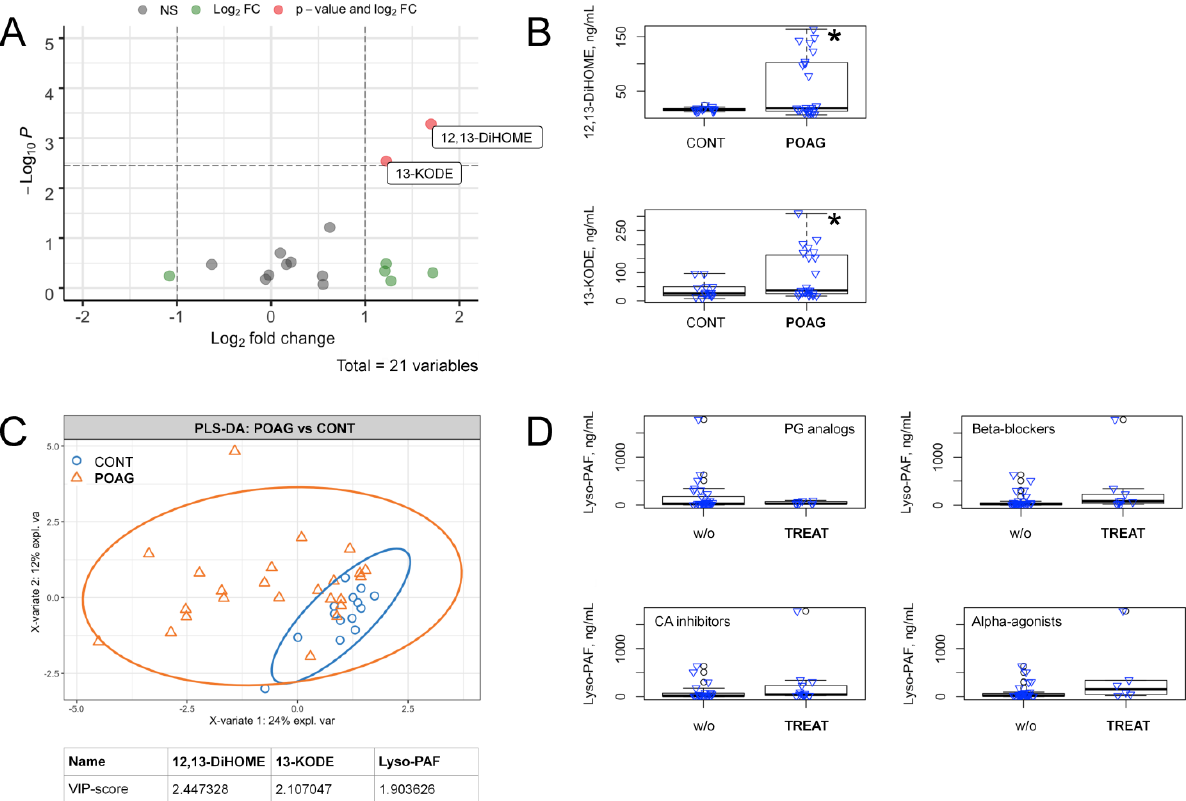
Figure 1. Alterations in the content of signaling lipids in AH in the total cohort of POAG patients. ( A ) volcano plot presents compounds discriminating the total POAG and control groups. The X-axis indicates a log2 fold change of age and gender-adjusted concentrations of the identified compounds in POAG patients as compared to the control individuals. The Y-axis indicates -log10 p -values with the cut-off calculated according to Bonferroni correction. Compounds that changed less than twofold (Log2 FC) or demonstrated non-significant (NS) alterations ( p > 0.05) are indicated in green and gray colors, respectively. The significantly changed compounds ( p < 0.05) are denoted in red color (value and Log2 FC). ( B ) the box plots demonstrating concentrations of metabolites exhibiting significant changes in glaucoma patients (POAG) as compared with control individuals (CONT). * p < 0.05 (adjusted for multiple testing). ( C ) the results of partial least square discriminant analysis (PLS-DA) revealing compounds distinguishing total glaucoma patients (POAG) from the control individuals (CONT). The explained variance of each component is indicated on the axes. Variable importance in projection (VIP) scores exceeding a cutoff value of 1.5 are considered. ( D ) the box plots illustrating pairwise comparisons of lyso-PAF concentrations in AH of POAG patients with (TREAT) or without (w/o) anti-glaucoma treatment using prostaglandins (PG) analogs, beta-blockers, carbonic anhydrase (CA) inhibitors or alpha-adrenergic agonists. In all cases p > 0.05.